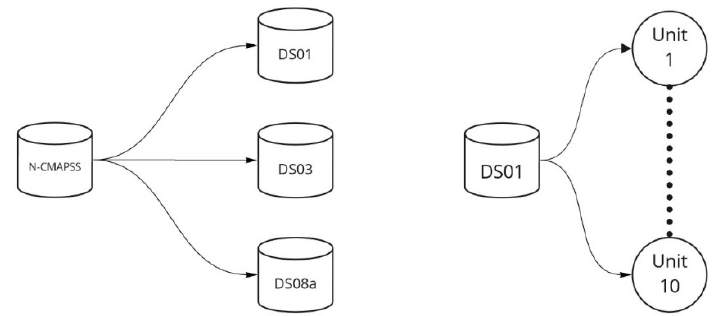
Figure 3. N-CMAPSS database structure .